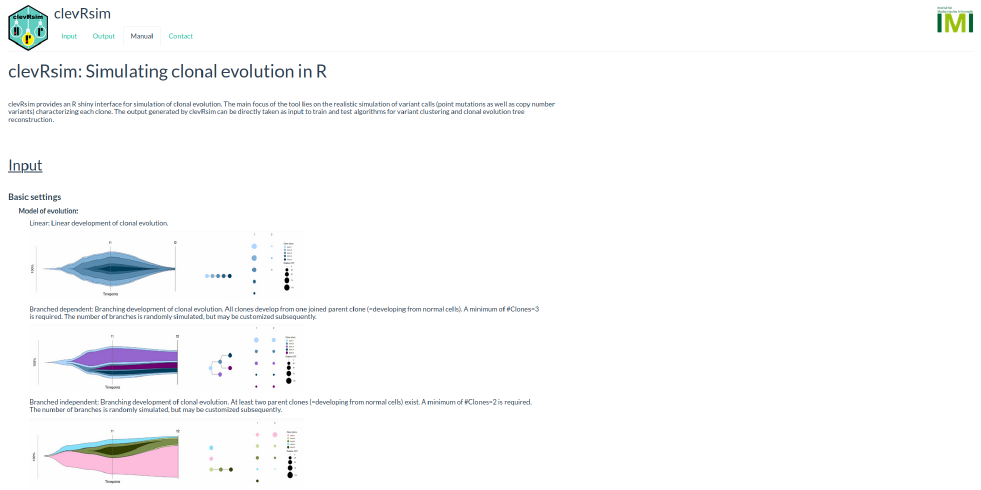
Figure A4. Manual with detailed information on the use of